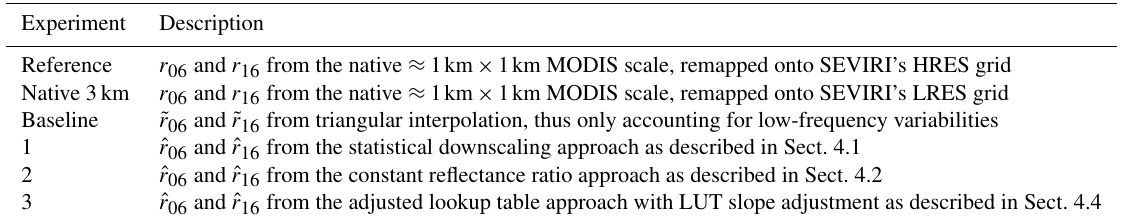
Figure 5. (a) RGB composite image of SEVIRI channel 3, 2, and 1 reflectances at the instrument’s native horizontal resolution of 3km × 3km. Data are from a ≈ 100km × 100km subregion within the Germany domain on 9 June 2013 at 10:55UTC. (b) Similar to (a) but illustrating a map of the cloud optical thickness ( τ ). White colors indicate pixel with either a failed cloud property retrieval, a nonliquid cloud phase, or noncloud designation by the cloud masking algorithm. (c) Same as (b) but for the effective droplet radius ( r eff ). (d) – (f) Same as (a) – (c) but at a horizontal resolution of 1km × 1km. The reflectances and retrievals have been derived from the adjusted lookup table approach as described in Sect. 4.4, using the LUT slope adjustment. Table 1. Description for the different retrieval experiments, which are characterized by different assumptions for the downscaling of SEVIRI reflectances from the native horizontal resolution of ≈ 3km to the MODIS-like ≈ 1km